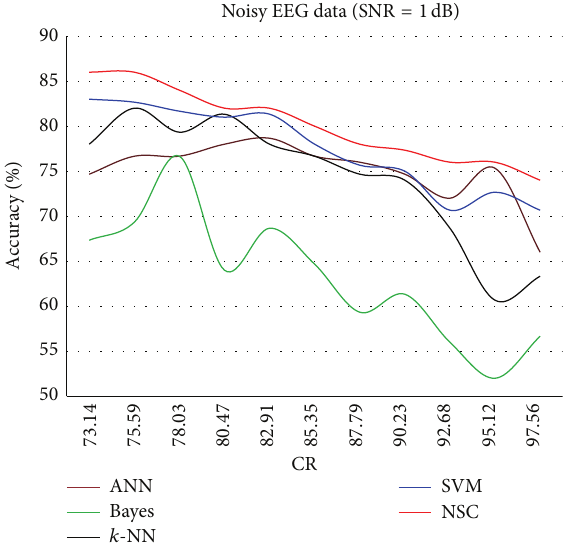
Figure 5: Classification accuracy against CR for SNR = 1dB.